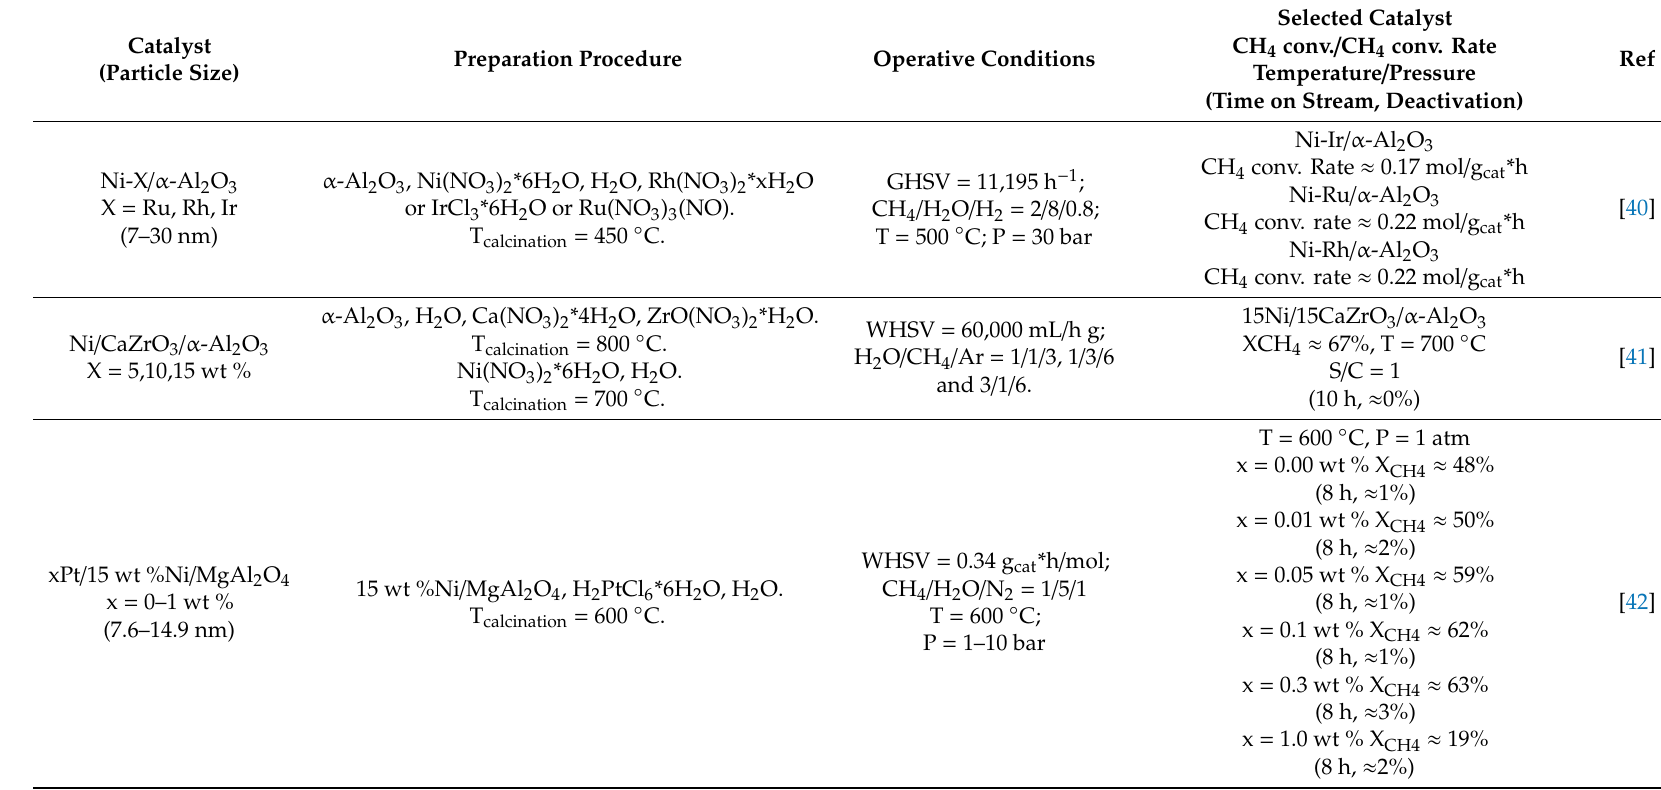
Table 2. Summary of preparation procedures and operative conditions used in polymetallic catalysts and related